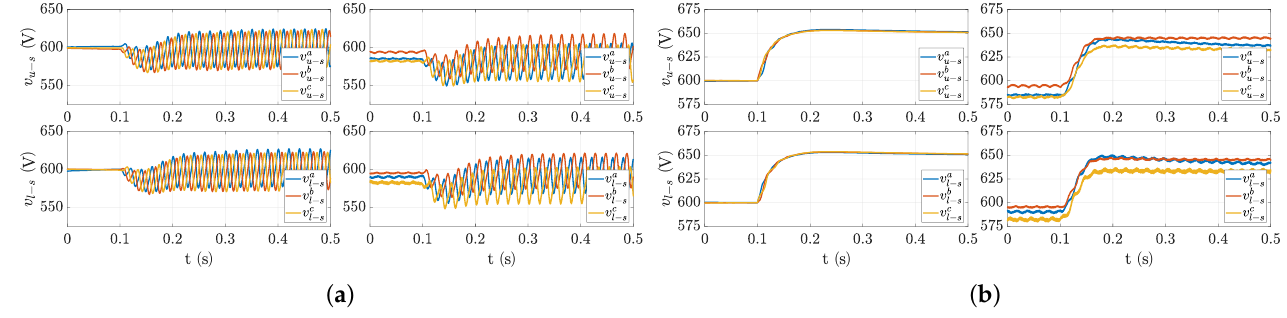
Figure 12. Simulation ( left ) and experimental ( right ) results, ( a ) showing capacitors (arm) voltage during a step change is applied to P from 0 to 1 pu ( b ) showing capacitors (arm cells) voltage during a step from 600 V to 650 V in the arms capacitors voltage.